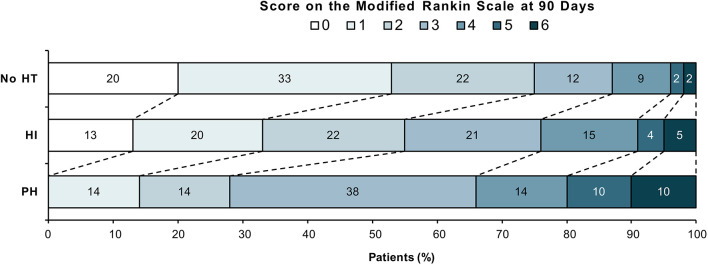
Distribution of Modified Rankin Scale scores at 90 days after stroke by hemorrhage groups. Modified Rankin Scale scores range from 0 to 6 (0, no symptoms; 1, no clinically significant disability; 2, slight disability; 3, moderate disability; 4, moderately severe disability; 5, severe disability; and 6, death). HT, hemorrhagic transformation; HI, hemorrhagic infarction; PH, parenchymal hemorrhage.